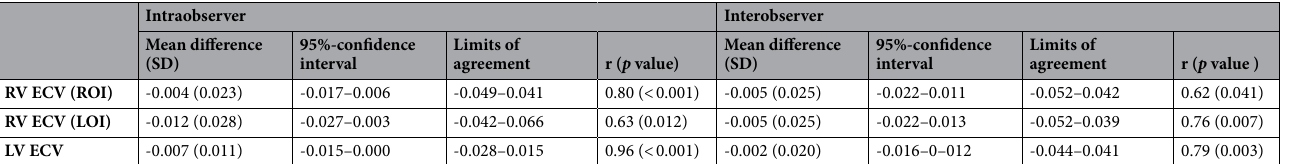
Table 5. Intra-and interobserver variability for extracellular volume across healthy controls and patients with congenital heart disease. ECV = extracellular volume; LOI = line of interest; r = Pearson´s correlation coefficient; ROI = region of interest; RV = right ventricle; SD = standard